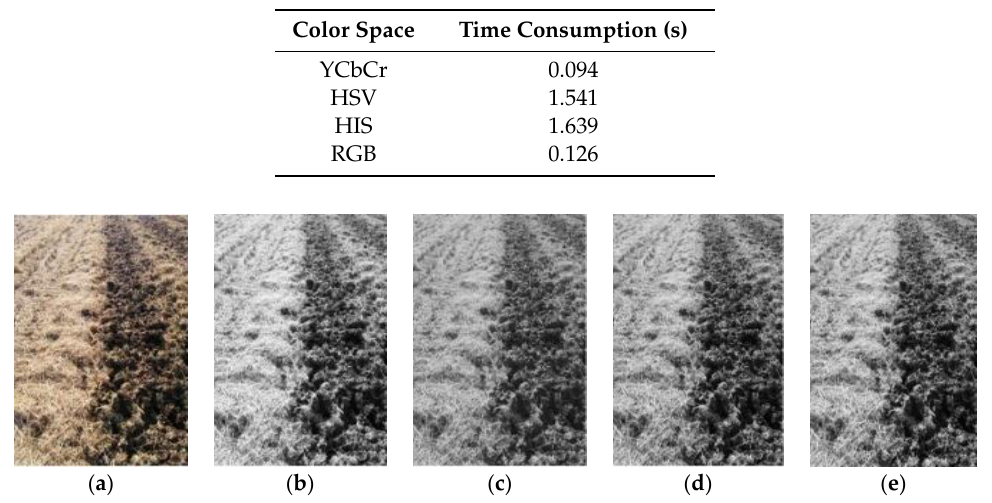
Figure 7. Component graph of each color space: ( a ) original; ( b ) Cr; ( c ) V; ( d ) I; ( e ) 2R-G-B.